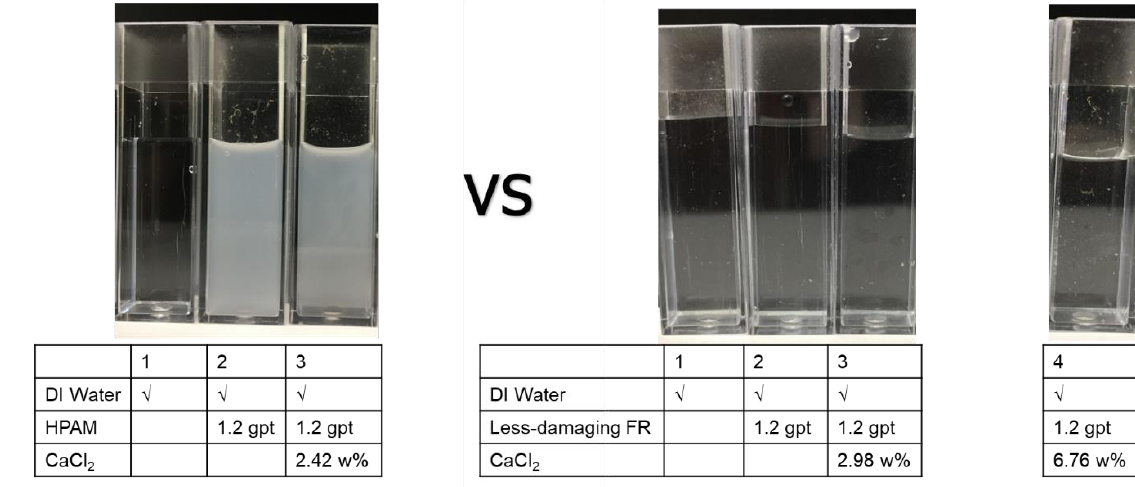
Figure 16—HPAM vs. a less-damaging FR in CaCl